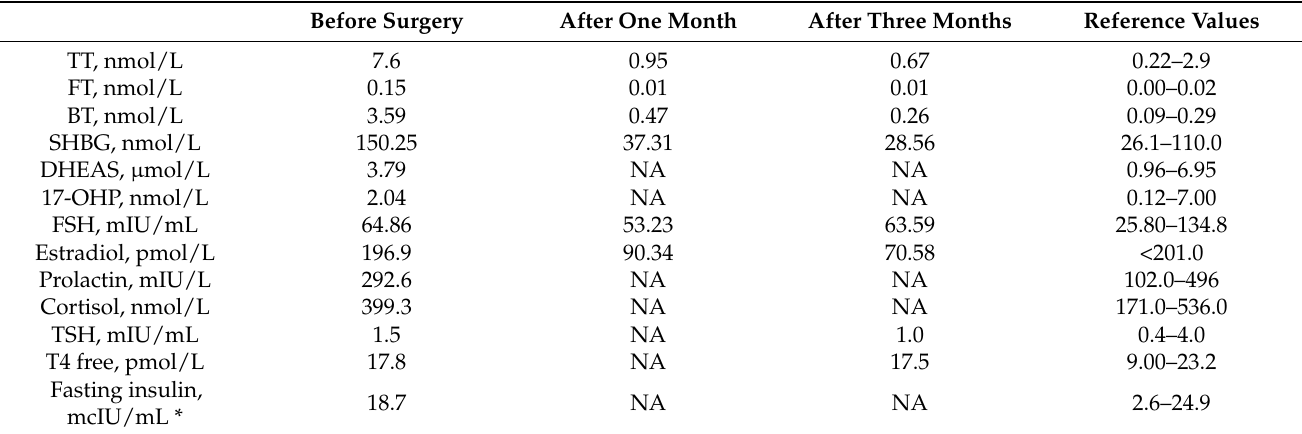
Table 1. Serum concentrations of chosen hormones before and 1 and 3 months after surgical treat- ment.